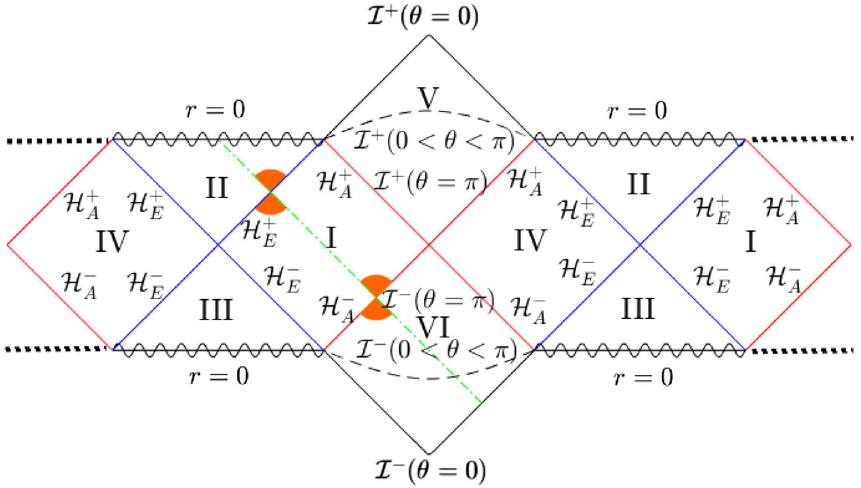
θ = π , and closes the diagram with a diamond shape for θ = 0. Since the metric is singular for θ = 0 ,π , the diagrams for those values do not represent the spacetime, so the conformal infinity in those cases has to be understood as a limit when θ → 0 ,π . The diagram is invariant under ϕ